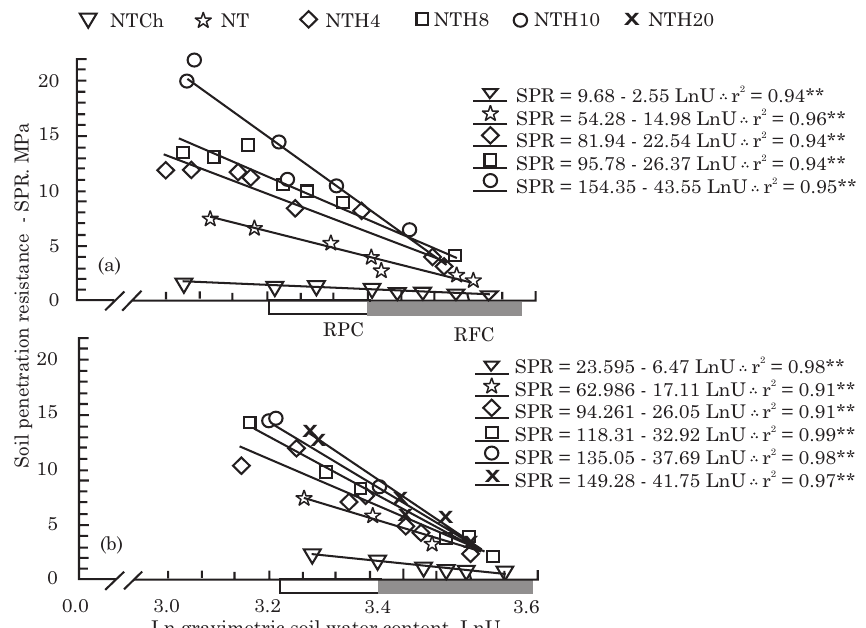
Figure 1. Variation of soil penetration resistance with gravimetric soil water content at each soil compaction level (NTCh = no-tillage with chiseling; NT = no-tillage without chiseling or additional compaction; NTH4, NTH8, NTH10 and NTH20 = NT with additional compaction by four, eight, 10, and 20 harvester passes, respectively), in the layer 5.5-10.5 cm (a) and 13.5-18.5 cm (b), in a Rhodic Eutrudox. **Statistically significant equations (F test, p<0.01). RPC = range of plastic consistency; RFC = range of friable consistency of soil.